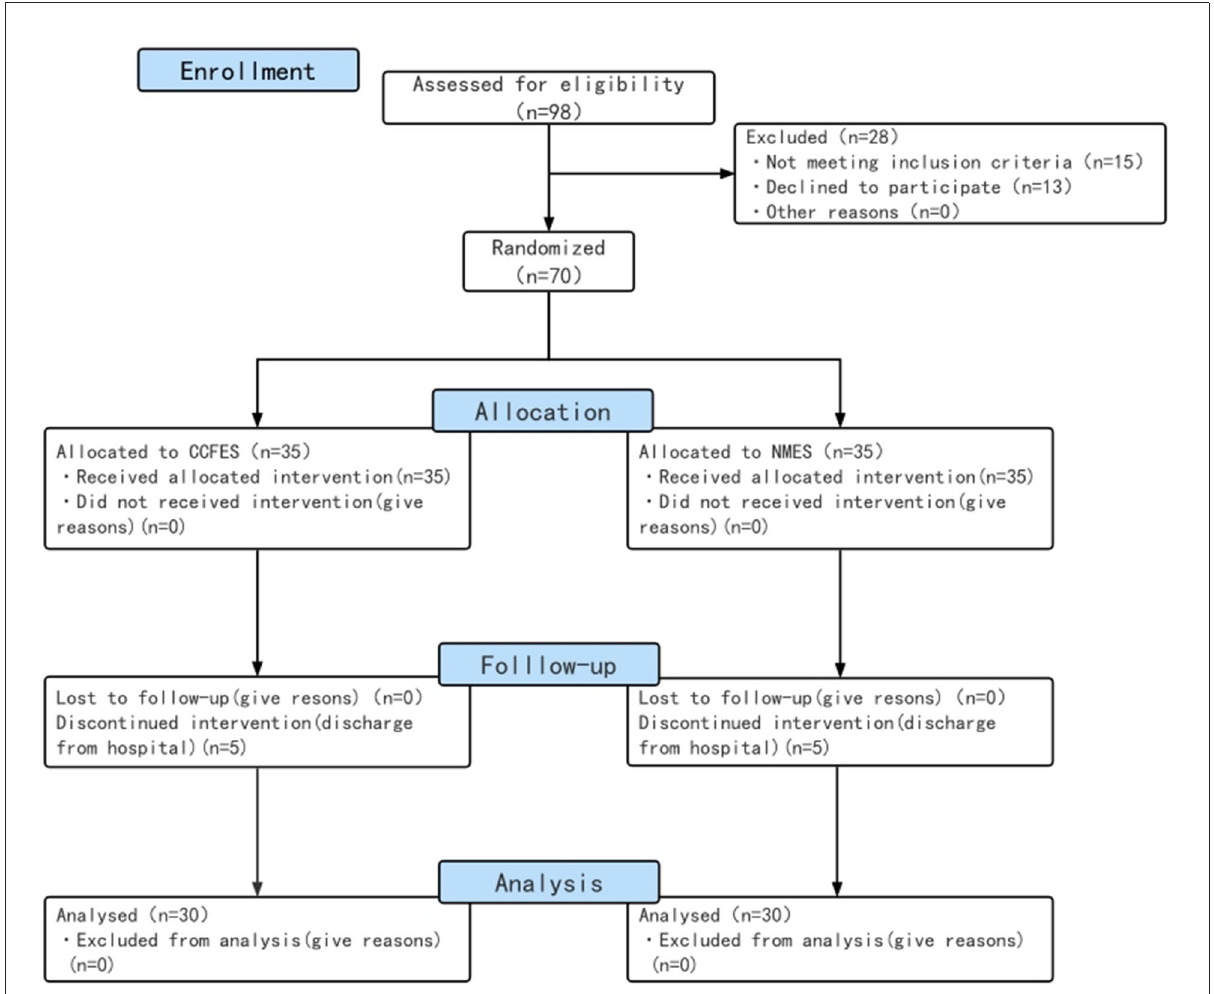
FIGURE1 Study flow diagram. CCFES, contralaterally controlled functional electrical stimulation; NMES, neuromuscular electrical